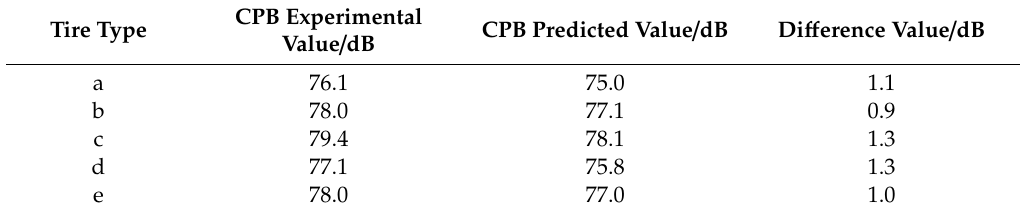
Table 5. Di ff erence between the measured value and the predicted value of CPB tire noise when ignoring the shielding e ff ect of the vehicle body on noise